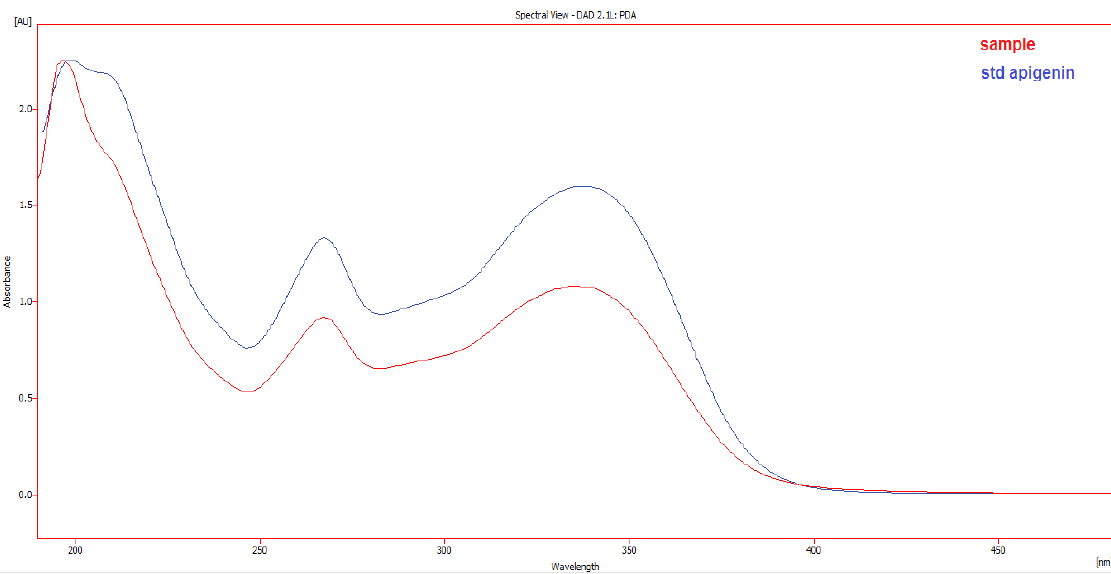
Figure 10. UV spectrum of fraction of ethyl acetate matched with apigenin standard UV